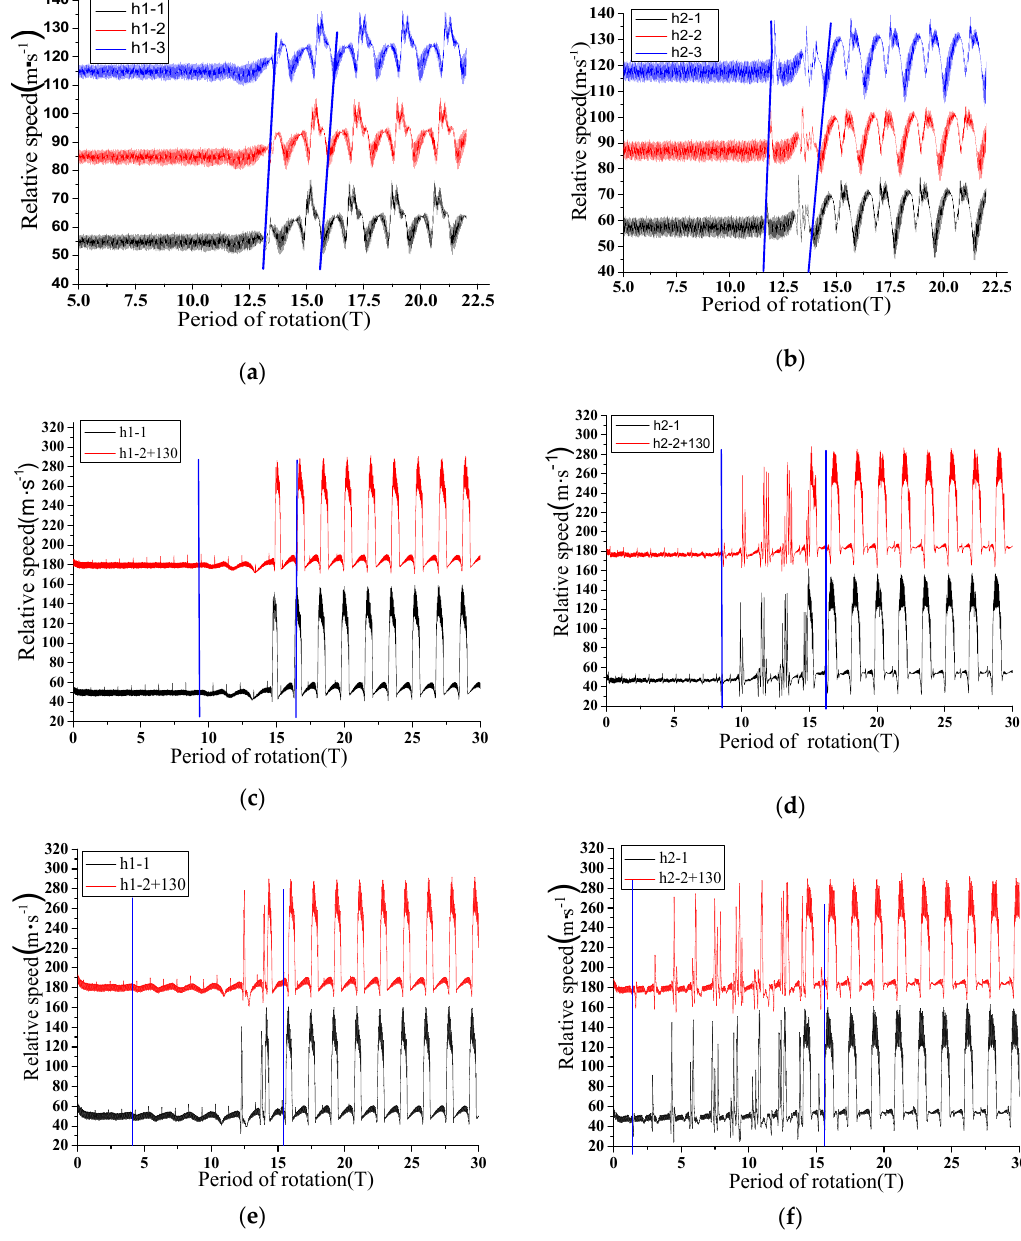
Figure 8. Curves of the relative speed at the monitoring points. ( a ) The first stage rotor under design angle. ( b ) The second stage rotor under design angle. ( c ) The first stage rotor when the abnormal deviation angle equal to − 6 ◦ . ( d ) The second stage rotor when the abnormal deviation angle equal to − 6 ◦ . ( e ) The first stage rotor when the abnormal deviation angle equal to +6 ◦ . ( f ) The second stage rotor when the abnormal deviation angle equal to +6 ◦ .